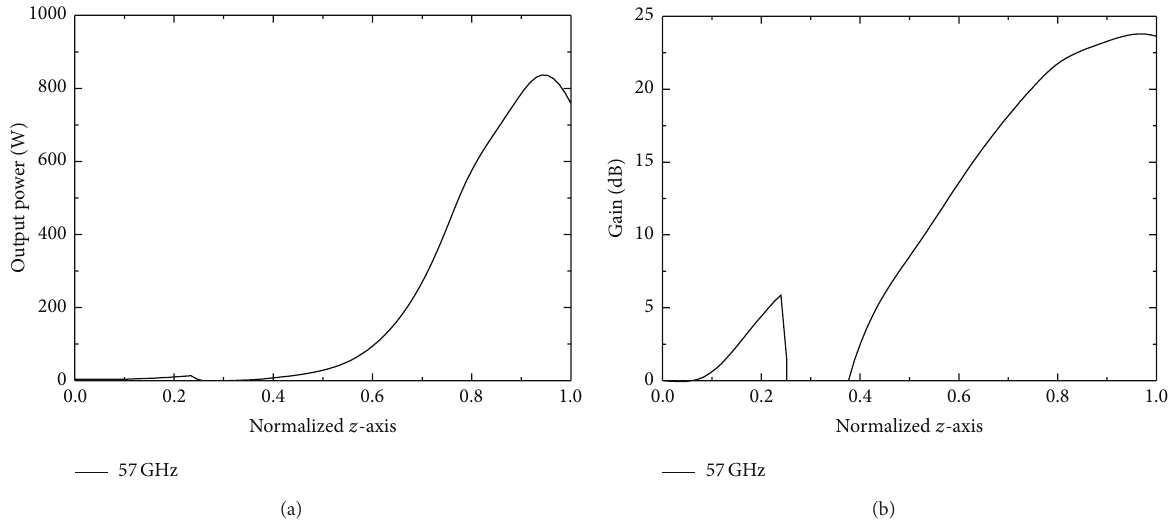
Figure 10: (a) Output power versus 𝑧 and (b) gain versus 𝑧 at 57 GHz of the FWG TWT (black and white).